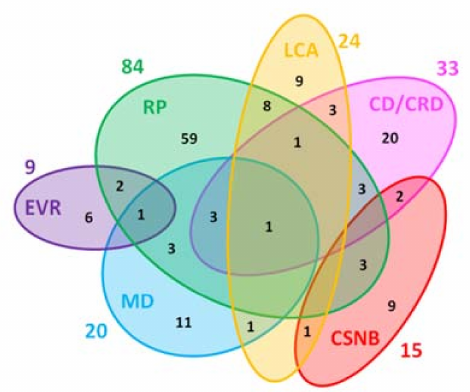
Figure 1. Genetic heterogeneity among the six major non-syndromic inherited retinal diseases (IRDs). Numbers outside of the ellipses correspond to the number of non-syndromic IRD genes responsible for the specific disease, while numbers within the ellipses correspond either to disease-specific genes or to genes mutated in two or more diseases. The non-redundant total of genes associated with these non-syndromic IRDs is 146. RP: retinitis pigmentosa; LCA: Leber congenital amaurosis; CD/CRD: cone dystrophy/cone-rod dystrophy; CSNB: congenital stationary night blindness; MD: macular dystrophy; EVR: exudative